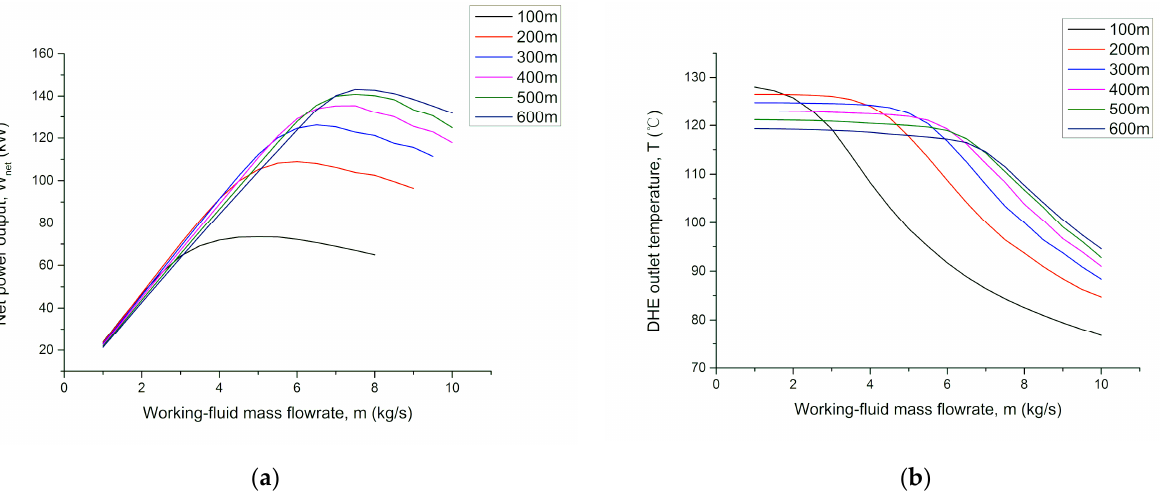
Figure 5. Effect of the DHE length on net power output ( a ), and working-fluid’s DHE outlet temperature ( b ) (working-fluid DHE inlet pressure = 11 MPa, geofluid temperature = 130 °C, geofluid mass flowrate = 5 kg/s, mass fraction of R32/CO 2 = 0.5/0.5).